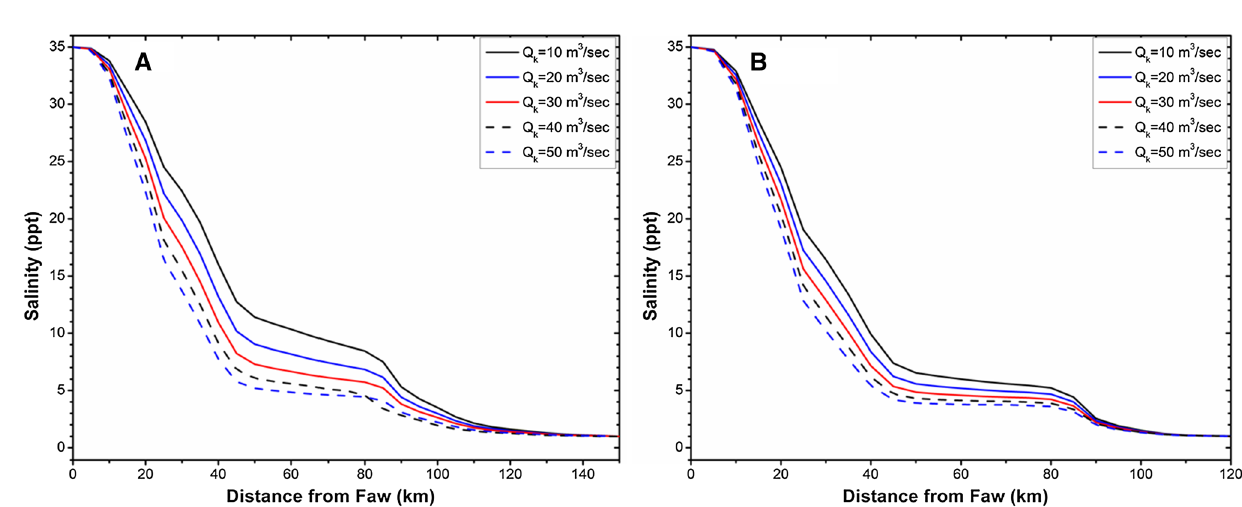
Fig. 8 Salinity intrusion limit corresponding to ( A : 25 m 3 /s and B : 50 m 3 /s) from Tigris and different flow rates from Karun